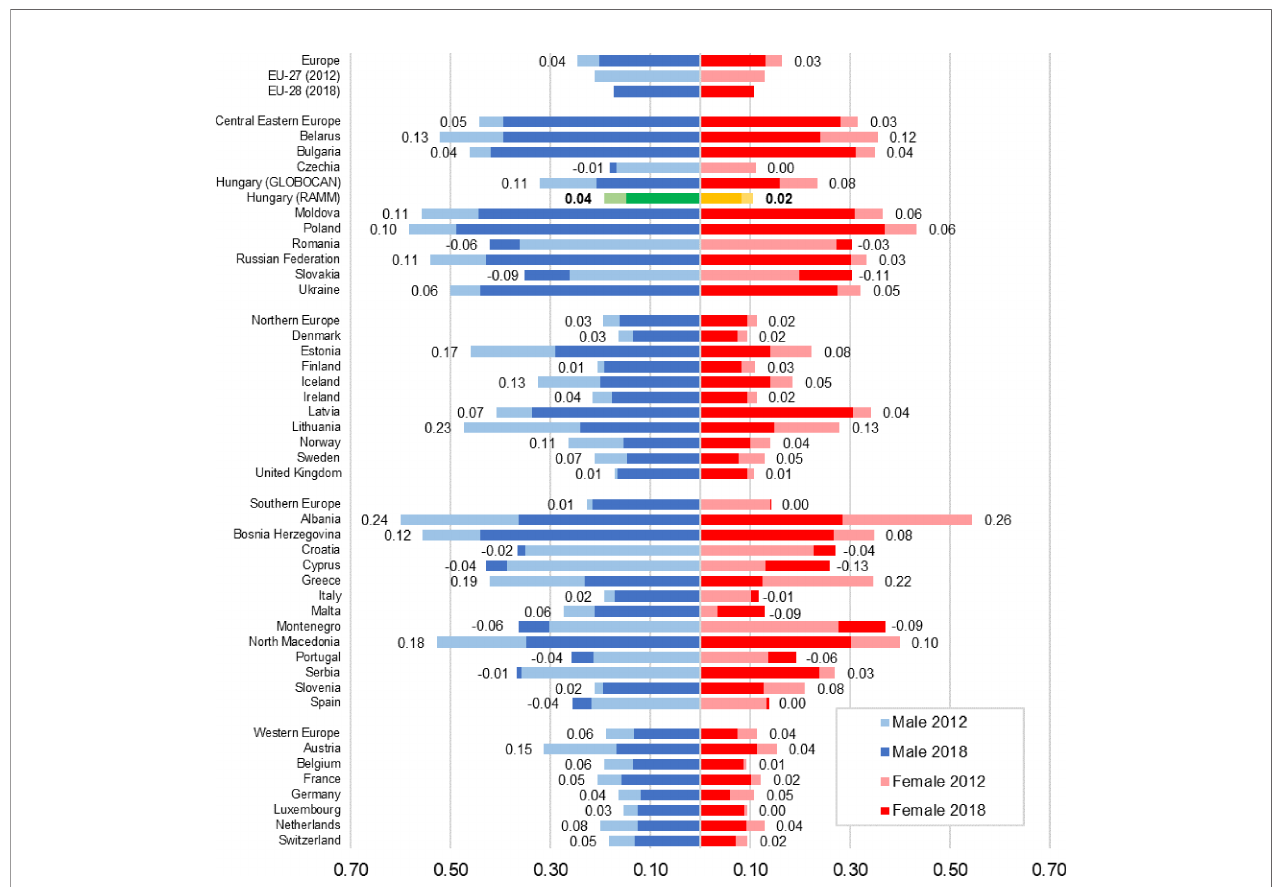
FIGURE 3 | Mortality-to-incidence ratios of melanoma by sex in Europe in 2012 and 2018 using the ESP 1976 dataset, all countries with data (numbers indicate the difference between 2018 and 2012 values). Note: Hungary (GLOBOCAN) refers to the publication of Ferlay et al. (4); Hungary RAMM refers to our fi ndings. Our fi ndings are highlighted with different coloration for distinction: males are green (2012 light, 2018 dark), women are yellow (2012 light, 2018 dark).